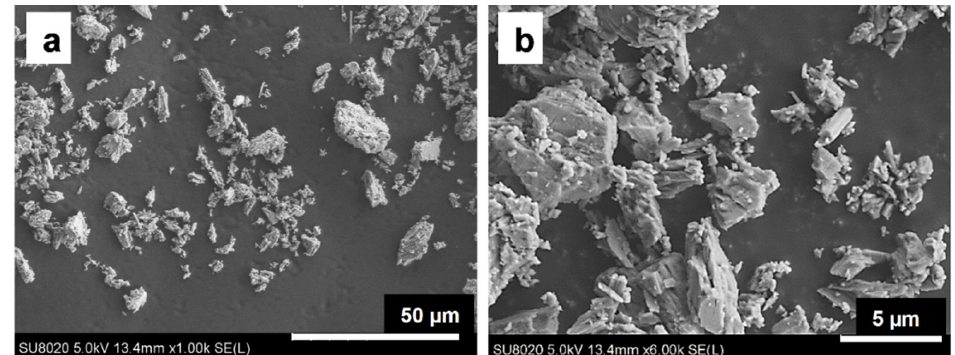
Figure 1. ( a , b ) SEM micrographs (SE mode) at different magnifications of AII microparticles. Tributyl citrate (TBC) was supplied by Sigma ‐ Aldrich with the following character ‐ istics: molecular weight = 360.4 g/mol, density at 20 °C = 1.04 g/mL, purity ≥ 99%.